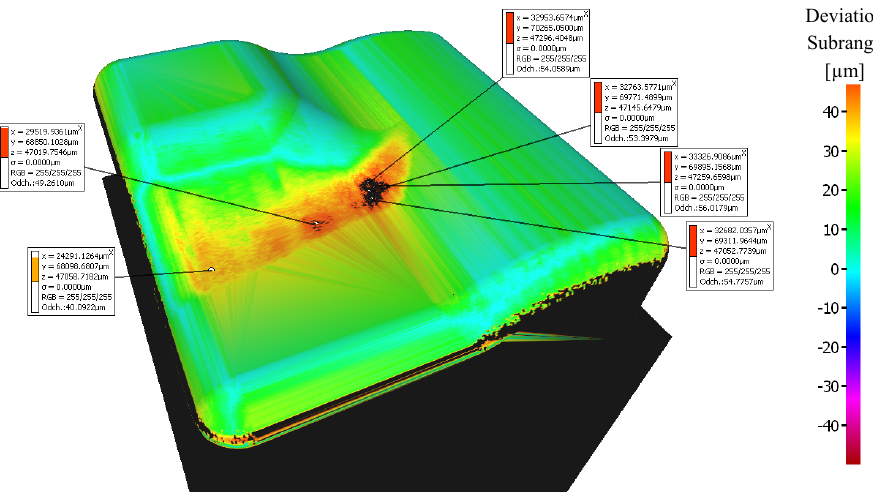
Figure 12. Comparison of the initial model with the workpiece after 3 + 2-axis milling (tool inclination β f = 10°, β n = 20°).